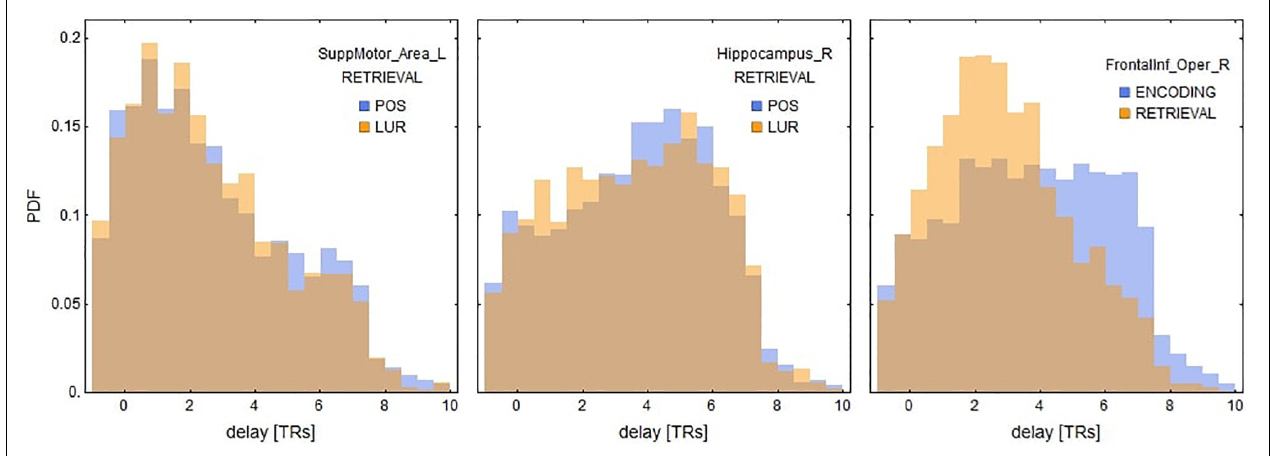
FIGURE 6 | Distributions of delays between the stimuli and the nearest BOLD peaks for three ROIs significant for retrieval in local information processing (see Table 3 ). These results suggest that the positive correlations of supplementary motor areas and inferior frontal gyri might be explained by the shorter delays, whereas negative correlations of hippocampal areas by relatively longer ones. See also Supplementary Figures 3, 4 for the delay distributions of all AAL